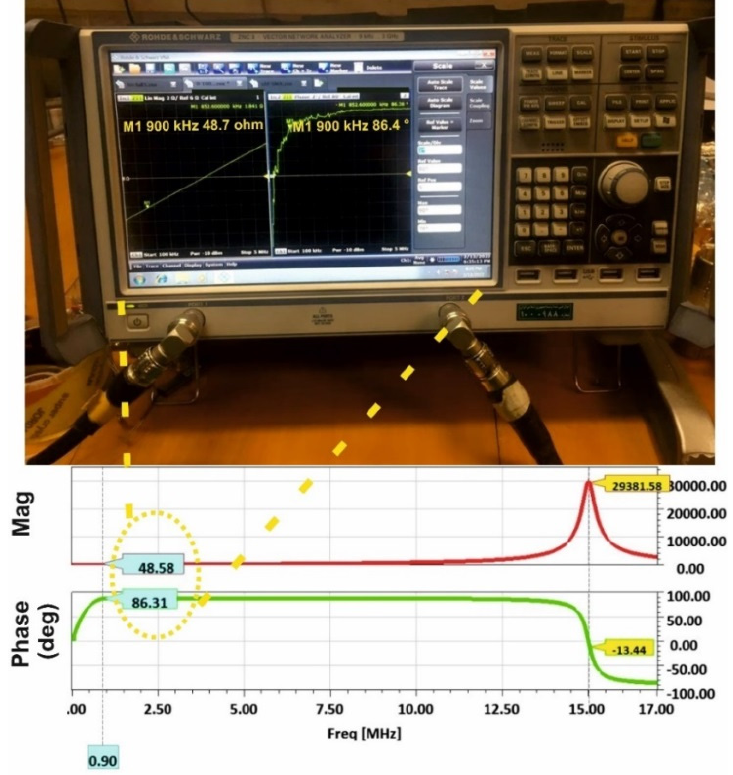
Figure 3. Impedance response of real and imaginary parts of Z 11 of the fabricated coil vs. frequency. As the external and internal coils are the same size, the coupling factor is stronger rather than in the case where the coils have different sizes. That is because, in larger external coils, as the internal coil is displaced from the center of the external coil (see Figure 1), the electromagnetic field distribution at bigger coil borders drops sharply. Here we use an array composed of four coils as external power transmitter coils. In this case, the electromagnetic field vector at the border of two neighboring coils is the result vector consisting of two horizontal and vertical field vectors. The horizontal field is canceled out because the external coils are the same size, and the direction of the field is opposite at the boundaries. So, only the field remains in the vertical direction. Therefore, the resulting magnetic field at the borders is much weaker than the fields at the center of each coil. The amplitude of the magnetic field above the center of the transmitter coil is greater than in the other positions. This change in the number of fields in the vertical direction is due to the change in angle (the angle between the center line of the transmitter coil and the receiver position). In blank spots, the angle increases and the field amplitude is reduced (cosine relation) until it is re-amplified via the next transmitter. Therefore, to obtain a uniform field distribution for the application of a free-moving object, we investigate the 50% overlap of coils for a uniform field